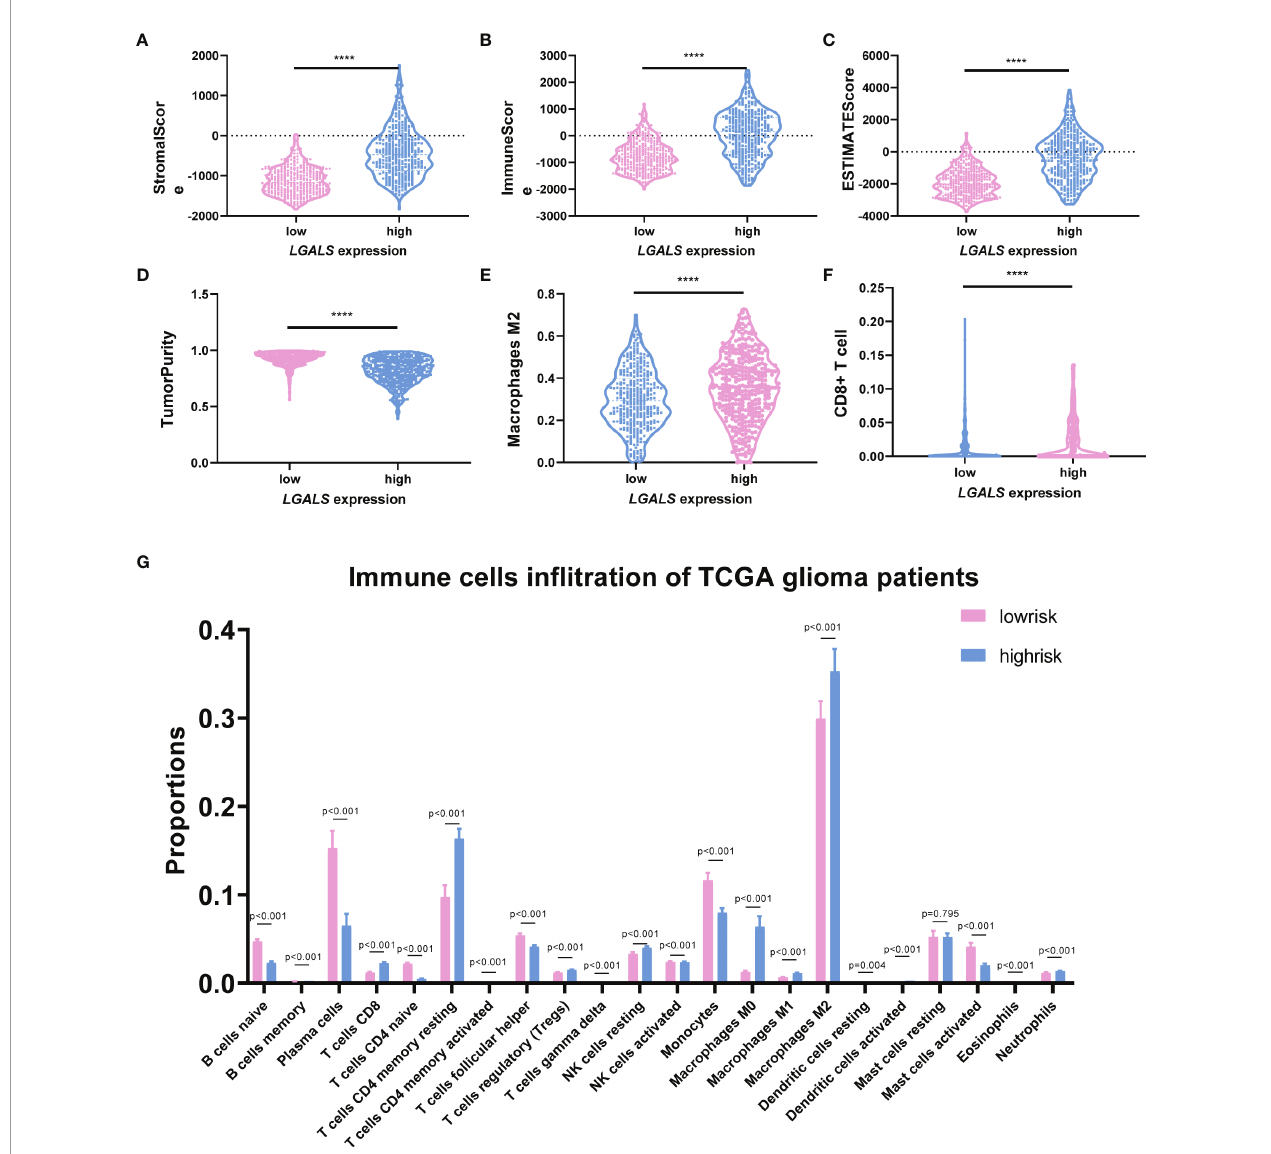
FIGURE 5 | LGALS expression indicates stromal cell in fi ltration and immunosuppression in TCGA Glioma dataset. (A) The StromalScore, (B) ImmuneScore, (C) ESTIMATEScore, and (D) TumorPurity of glioma patients with high and low LGALS expression based on LGALS signature. (G) The immune cells in fi ltration of glioma patients with high and low LGALS expression based on LGALS signature; the proportions of 22 immune cells were calculated. The proportion of macrophage M2 (E) and CD8 + T cell (F) was shown separately